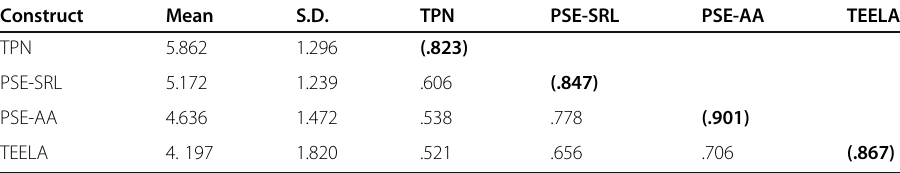
Table 5 Descriptive statistics, correlation matrix and discriminant validity